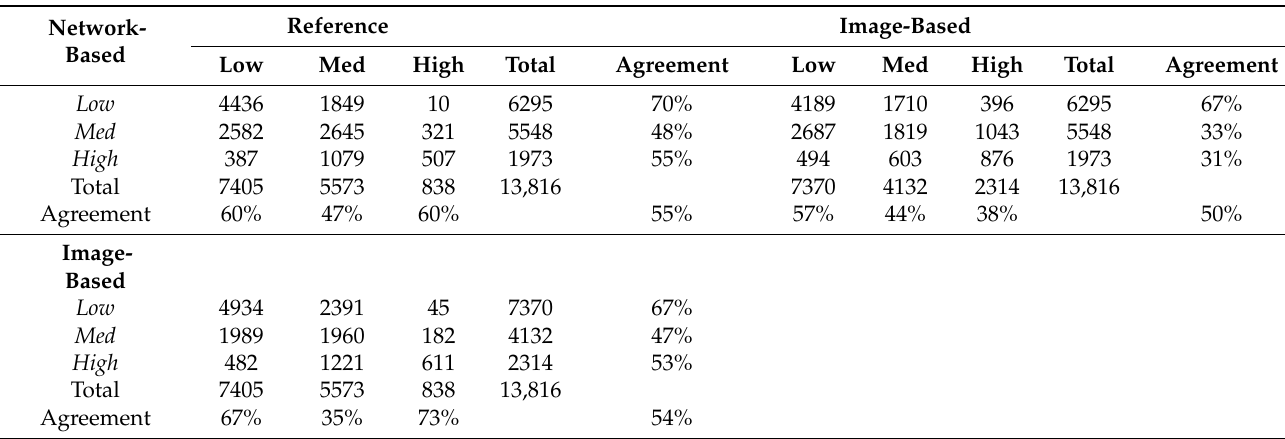
Table 3. Three-way confusion matrix showing class agreement between the network-based, image-based and reference road characterization approaches for the three classes low use, medium use and high use. Values are in km of road segments classified to each road use. Agreement is calculated as the percent of the total km of road segments for a given row or column that were classified the same between the two respective